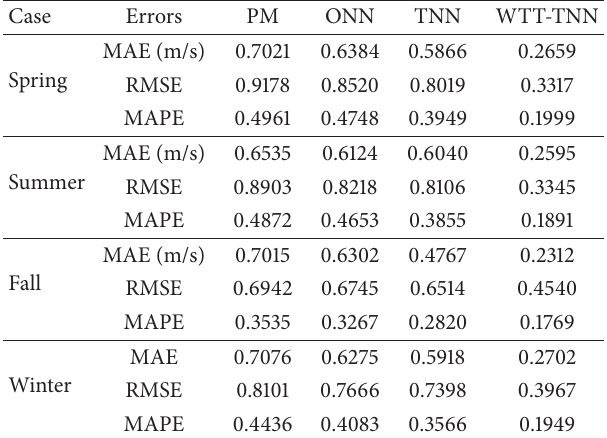
Table 5: The prediction results using PM, ONN, TNN, and WTT- TNN.